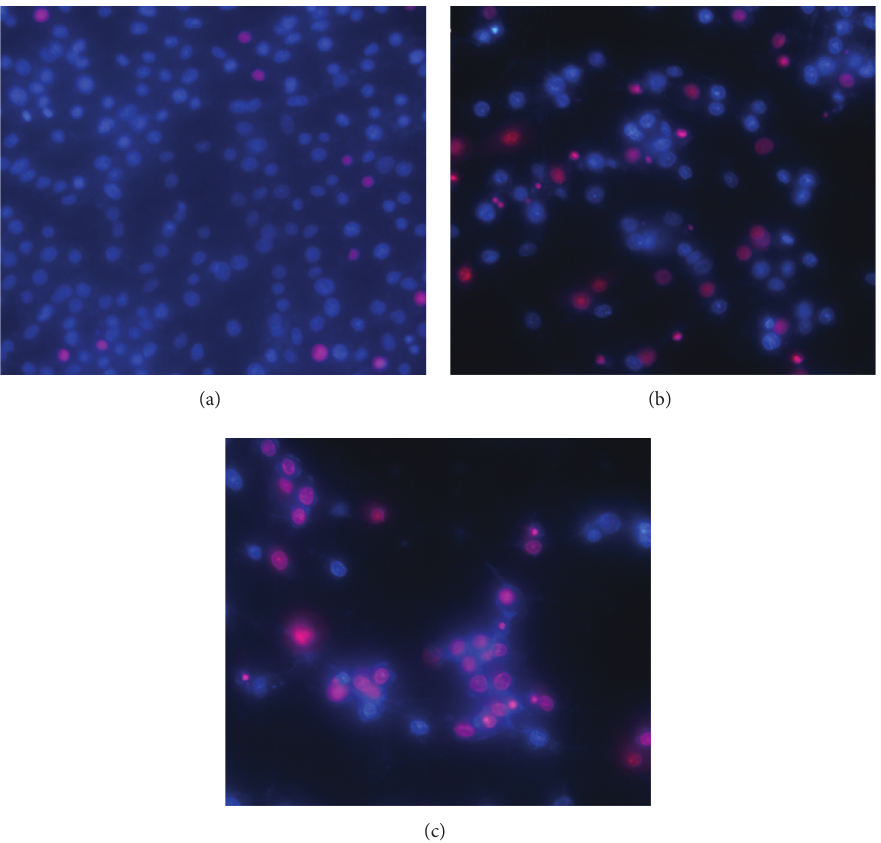
Figure 4: Propidium iodide (PI) and Hoechst 33342 double staining in cultured C6 cells 72 hours after 400 𝜇 M ganciclovir (GCV) administration ( × 400). Cells emitting blue fluorescence were Hoechst positive while those with red fluorescence were PI positive. Although PI positive cells (dead cells) were rare in control group (a), their number increased significantly in C6-TK (b) and C6-sr39TK group (c) (C6-TK versus C6-sr39TK, 𝑃 < 0.001 ).